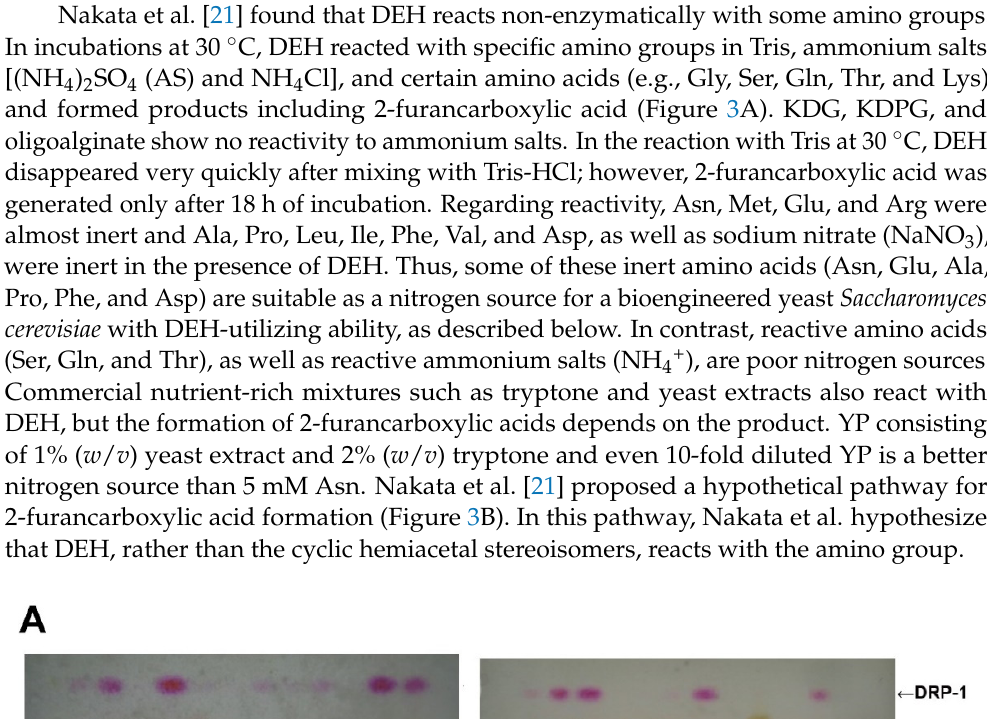
Figure 3. Reactions of DEH. ( A ) Reactivity of DEH with ammonium salts and amino acids. DEH (1% w / v , 56.8 mM) was incubated with 50 mM amino acids and ammonium salts at 30 °C for 24 h, with the exception of Tyr, Trp, and Asp, which were used at 1.0, 20, and 12.5 mM, respectively, because of their insolubility [21]. Figure modified from Figure 2A in ref. [21]. ( B ) Hypothetical pathway for the formation of 2-furancarboxylic acid from NH 4+ and DEH or Dhu. Dhu is formed from a D -glucuronic acid residue via unsaturated glucuronic acid [28]. Figure modified from Figure 5 in ref. [21]. 3. DEH Reductase 3.1. Discovery and Classification of DEH Reductase As described above, Preiss and Ashwell first identified a NADPH-dependent reductase for alginate metabolism in Pseudomonas in 1962 [29]. This reductase catalyzes the reduction of DEH to KDG in the presence of a coenzyme, and the enzyme activity is significantly expressed in alginate-grown bacterial cells in comparison with glucose- grown cells. However, molecular cloning of the gene for the enzyme was not achieved for about 50 years until 2010, because DEH was considered to be an attractive compound after we realized the significance of the biofuel production from alginate. The Gram-negative Sphingomonas sp. strain A1 is one of the most well-studied alginate-assimilating bacteria [30] (Figure 4). Strain A1 cells incorporate alginate polysaccharide through a cell surface pit and an ATP-binding cassette (ABC) transporter [31,32]. Periplasmic alginate-binding proteins (AlgQ1 and AlgQ2) deliver alginate from the pit to the ABC transporter, which has membrane-spanning domains (AlgM1 and